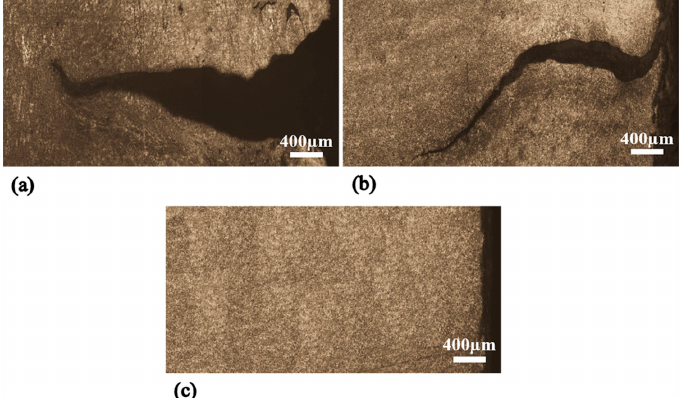
Figure 5. The optical micrograph of the edge cracks of the sheets rolled at different temperatures: ( a ) 150 °C, ( b ) 200 °C, and ( c ) 250 °C.